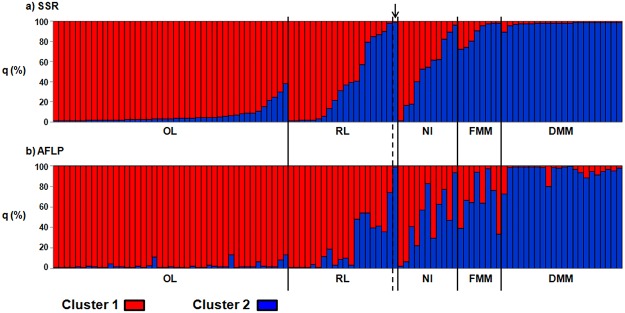
Population structure at accession level.Average percentages of membership to cluster 1 (q1, red) and cluster 2 (q2, blue) for each of the 104 accessions for the SSR (a) and AFLP (b) molecular markers. Each accession is represented by a vertical bar divided into two coloured segments, the lengths of which indicate the proportions of the genome attributed to cluster 1 and cluster 2. The arrow indicates the control accession ANGRMC13.